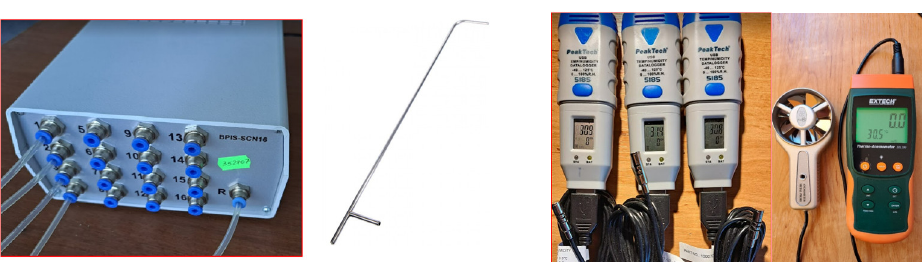
Figure 7. Measuring devices: Electronic scanner with 16 measurement pressure points; Pitot tubes, temperature, and relative humidity (RH) data logger; The thermo-anemometer type SDL300. The air velocity (v) is calculated with Formula (1) [34], using the dynamic pressure (pd) indicated by the Electronic Pressure Scanner as the difference between the total pres- sure (pt) and the static pressure (ps) measured with the Pitot tubes: